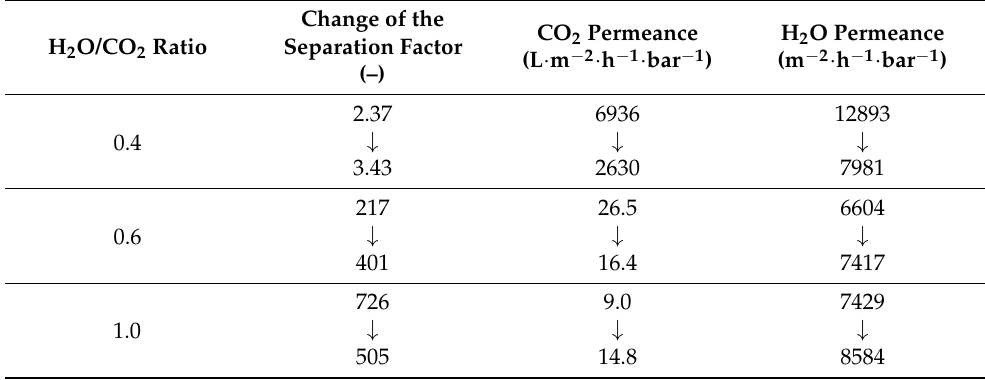
Table 2. Separation behaviour of the MFI membranes before and after the amine